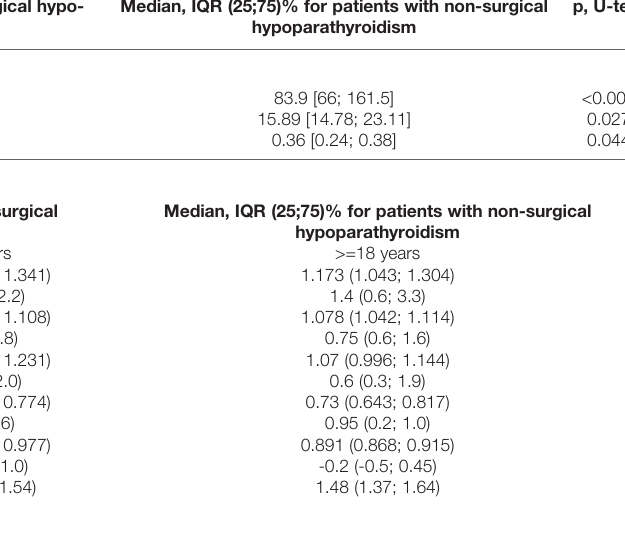
TABLE 3 | Bone turnover markers, bone mineral density (BMD) and Z-score in patients with postsurgical and non-surgical hypoparathyroidism. Bone turnover markers Median, IQR (25;75)% for patients with postsurgical hypo-